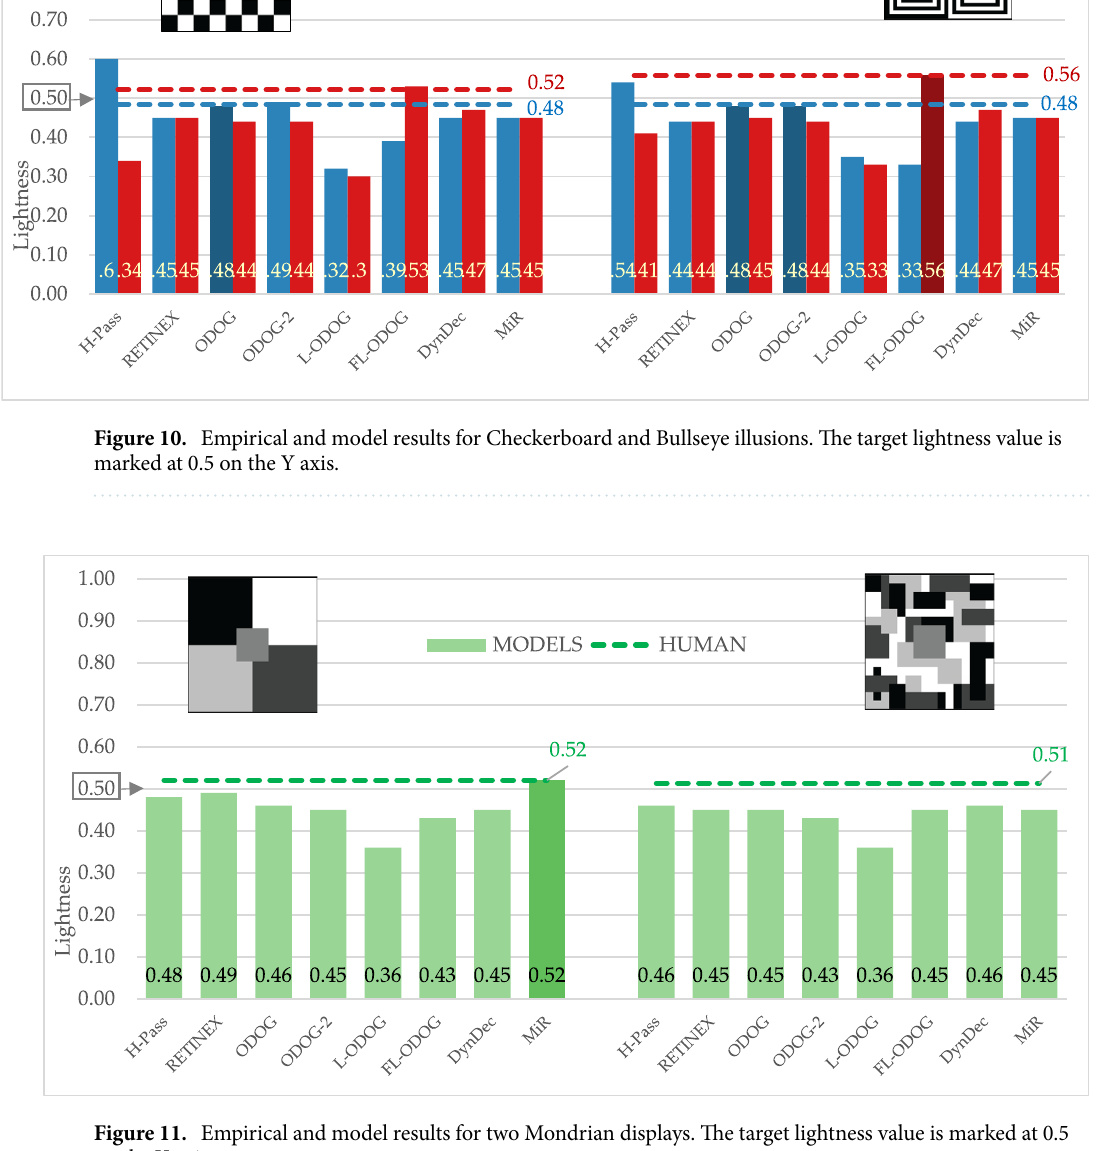
Figure 11. Empirical and model results for two Mondrian displays. The target lightness value is marked at 0.5 on the Y